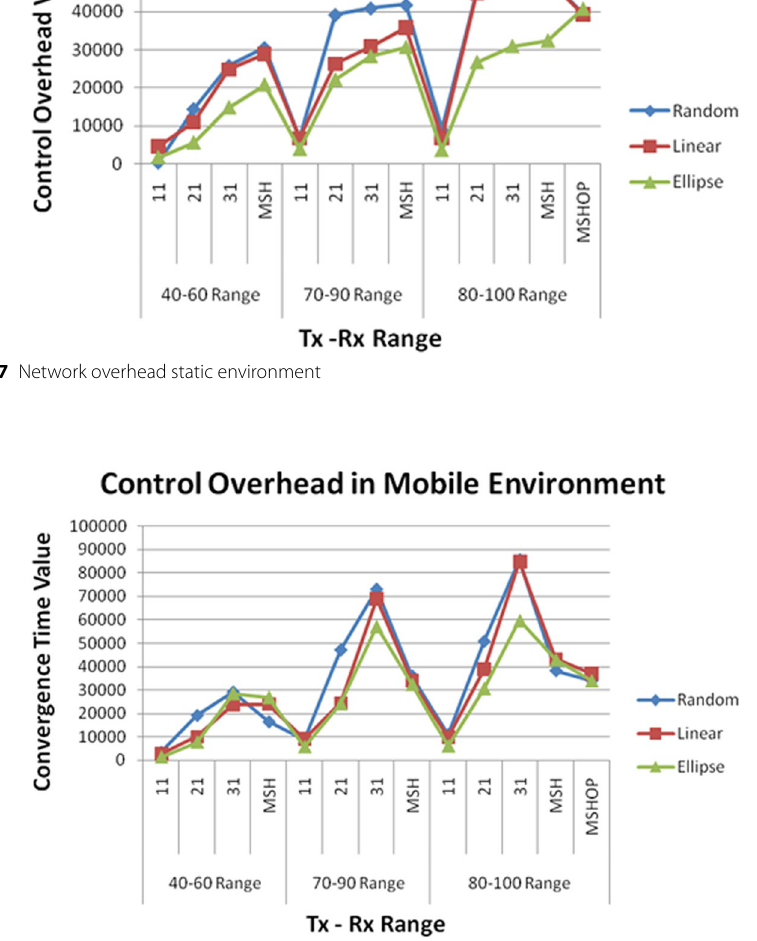
Fig. 28 Network overhead mobile